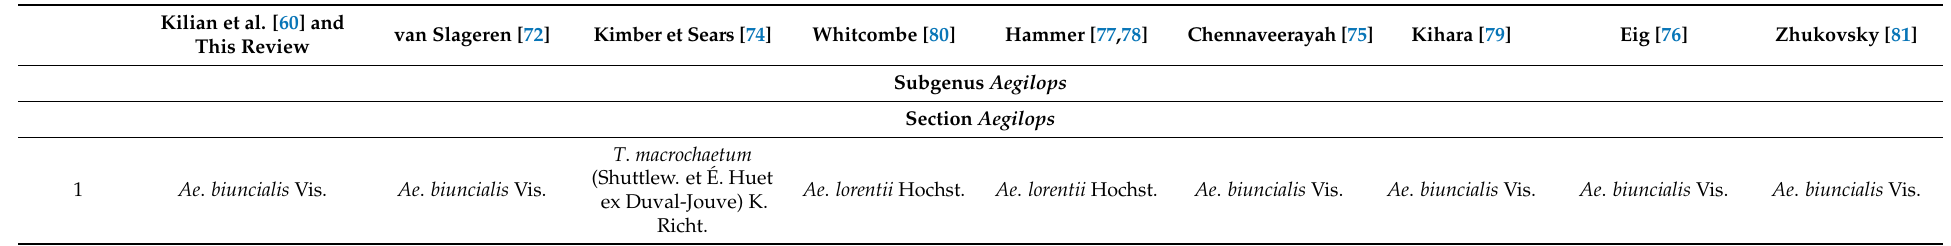
Table 3. Overview of selected Aegilops classifications. Botanical author abbreviations are according to IPNI (https://www.ipni.org accessed on 21 September 2021). Kilian et al. [60] and This